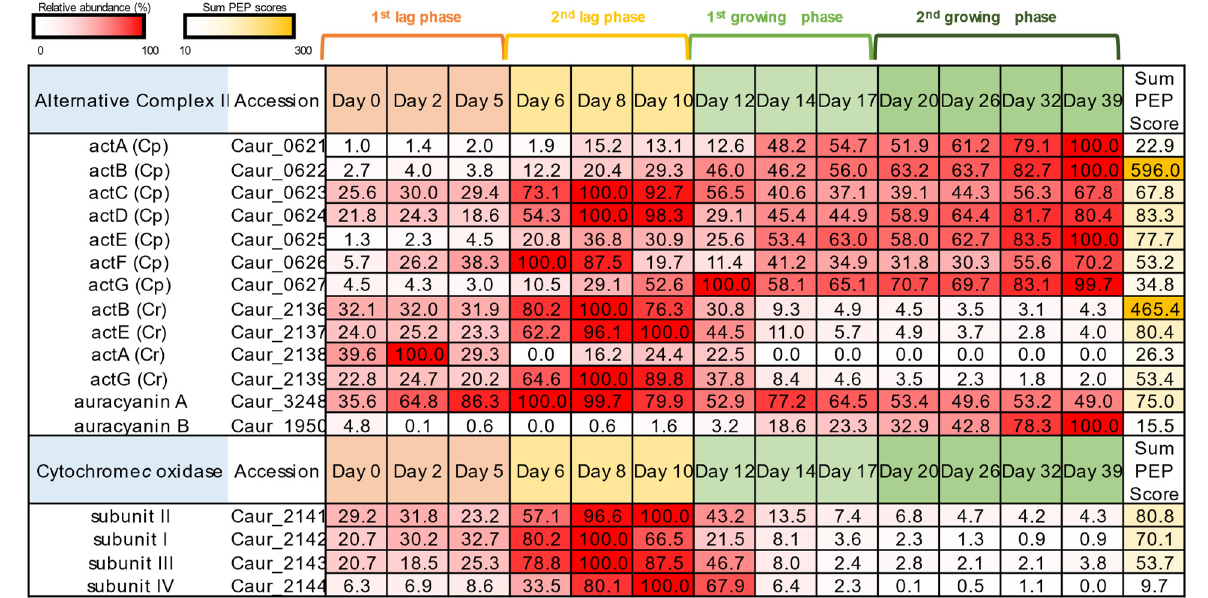
Figure 3. The relative abundance of proteins involved in photosynthetic and respiratory electron transfer chains. Relative values of protein expression among 13 sampling dates and Sum PEP scores are shown as described in Figure 2.